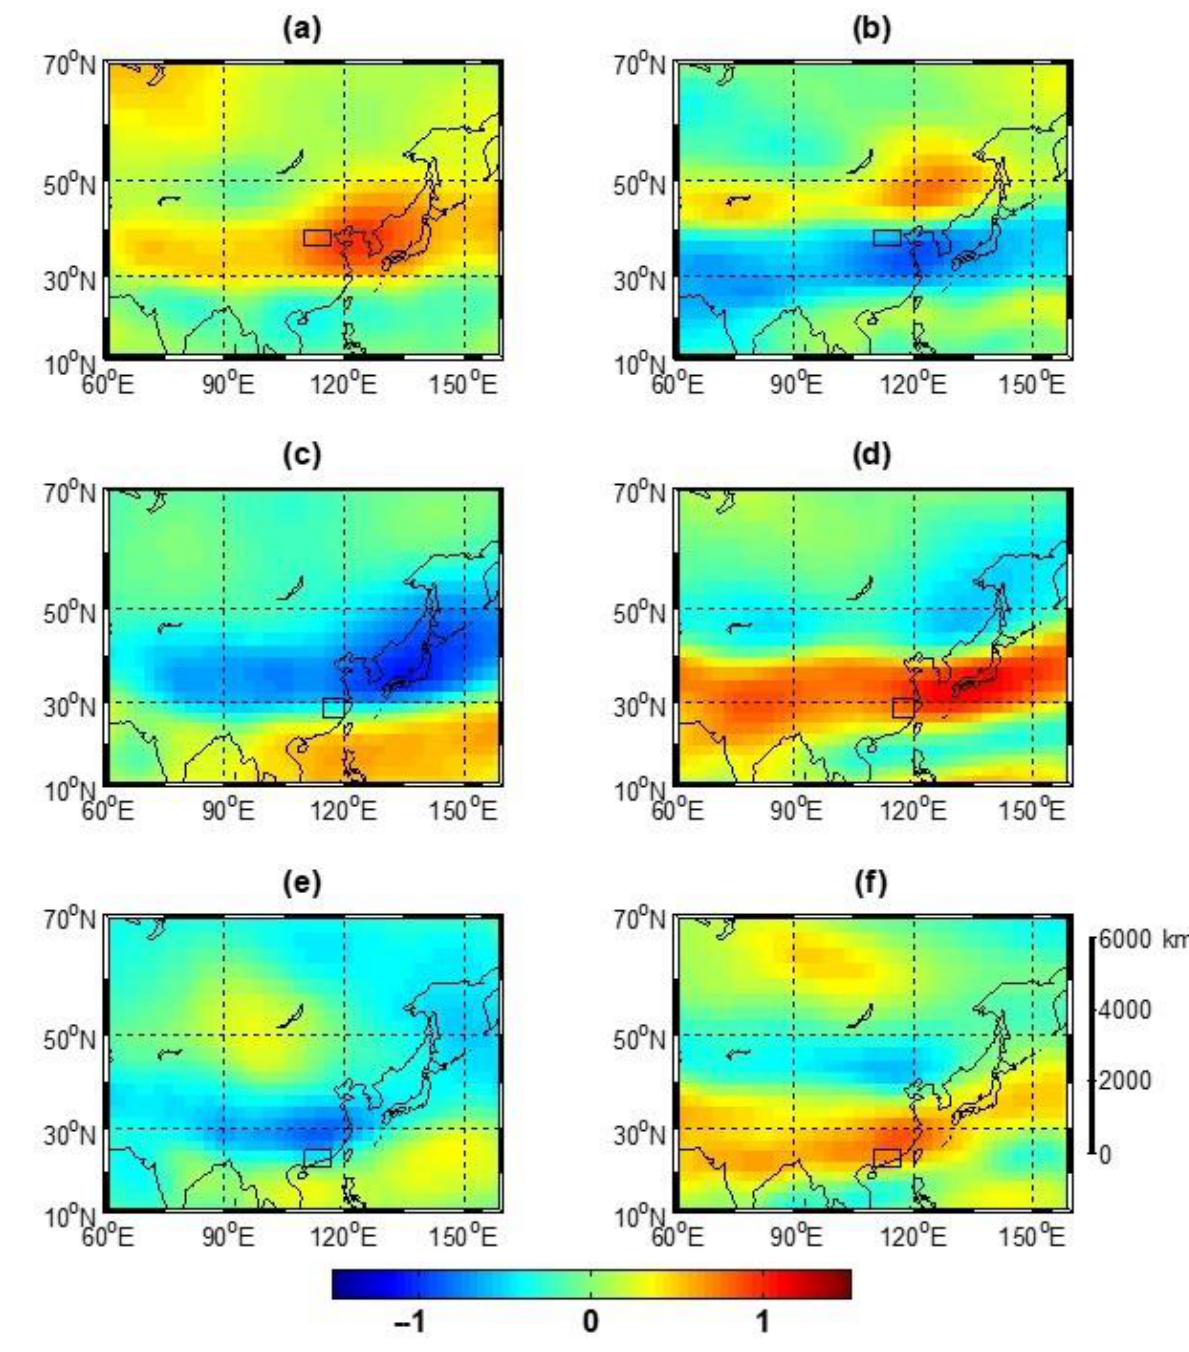
Figure 2. Composite of NCEP2 500-hPa geopotential-height standardized anomalies ( left column) and 200-hPa zonal winds standardized anomalies ( right column) for extreme event days in ( a , b ) North China (NC), ( c , d ) Yangtze River Valley (YRV), and ( e , f ) South China (SC) for JJA 1980–2019. height field (the western Pacific subtropical high pressure is latitudinal and extends west- ward to the east-central region of China) is stable near the Bohai Sea and the Korean Pen- insula, and its northwest side is a shallow trough in the westerly wind belt (the negative